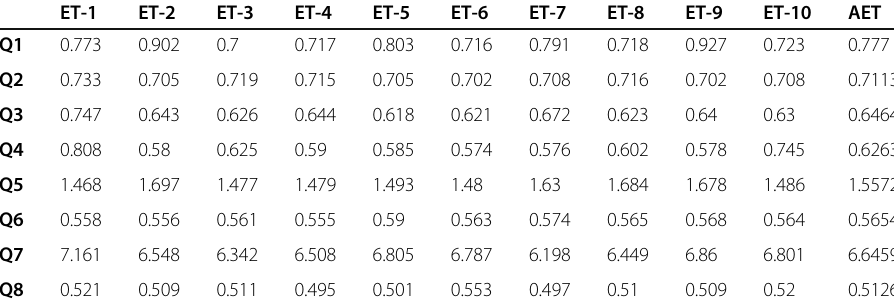
Table 11 Query execution time for RDS with Washington State data for